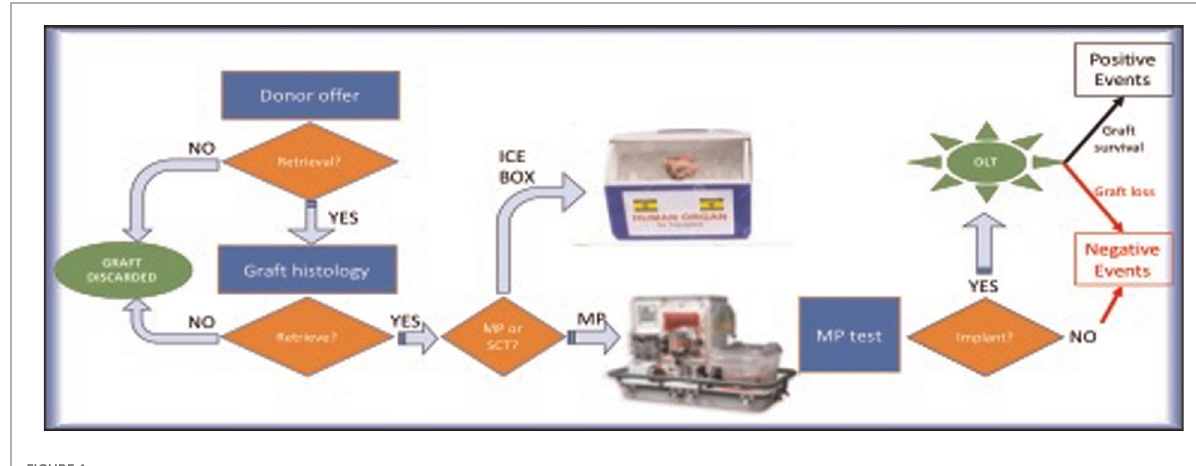
FIGURE 1 Decision-making process from the donor offer to the transplant and graphic presentation of the two study